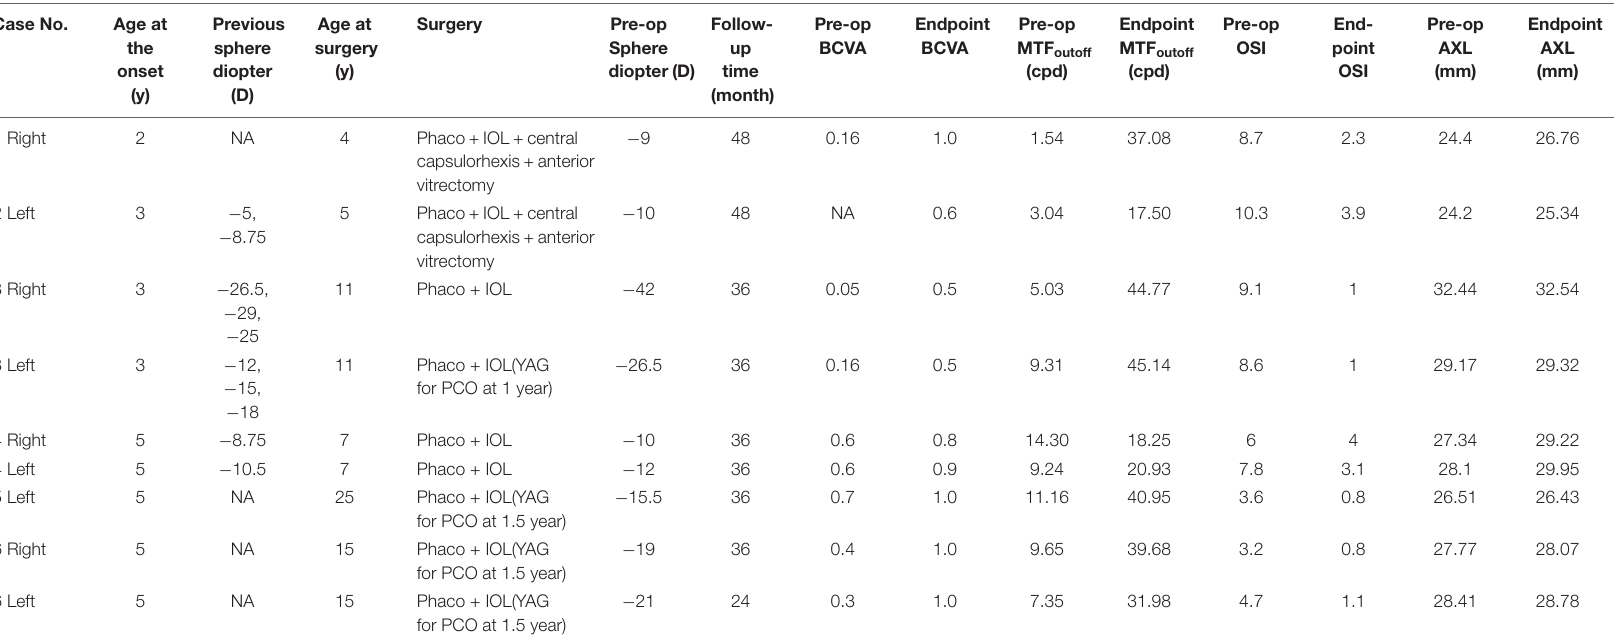
TABLE 1 | Clinical characteristics and retinal image quality by case number and operative eye of patients, organized by age at the onset. Case